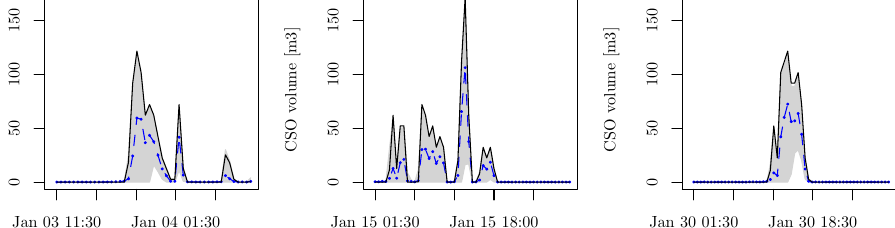
Figure 3. January 2016 time series of deterministic simulation (continuous black line), mean (dotted blue line), and 95% prediction band (grey band) of the Monte Carlo simulation at 30-min time step for simulation and analysis of water volume. Time series window for precipitation (top), water volume in the combined sewer overflow (CSO) chamber (second), detailed snapshots for water volume in the CSO chamber (third), and spill water volume of CSO